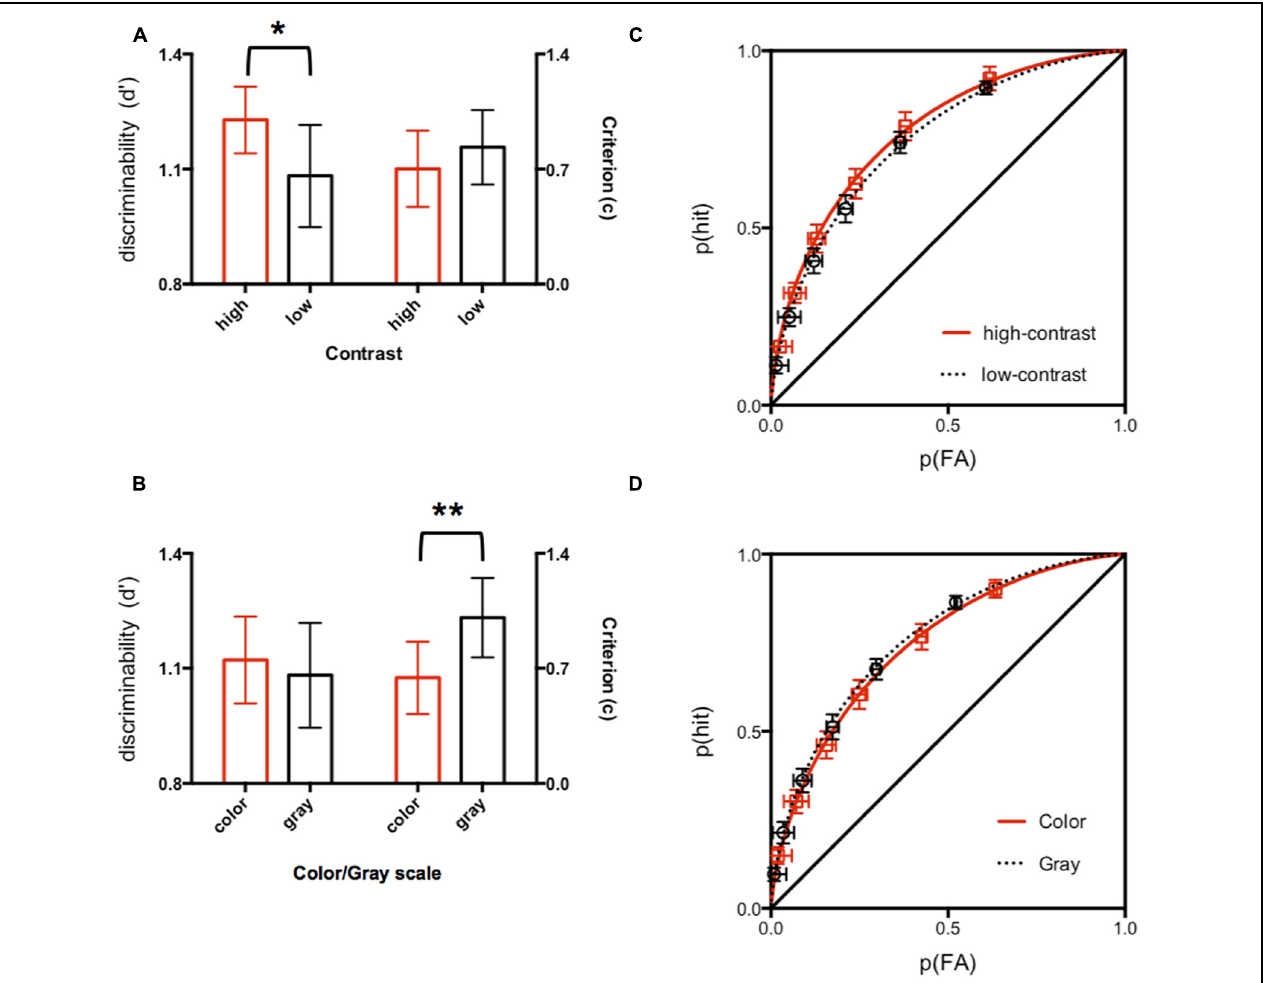
FIGURE 2 | (A,B) The discriminability (plotted on left y -axis) and criterion (plotted on right y-axis) extracted from ROCs (C,D) from aggregated data for the two experiments. ∗ indicates p < 0.05, ∗∗ indicates p < 0.01.